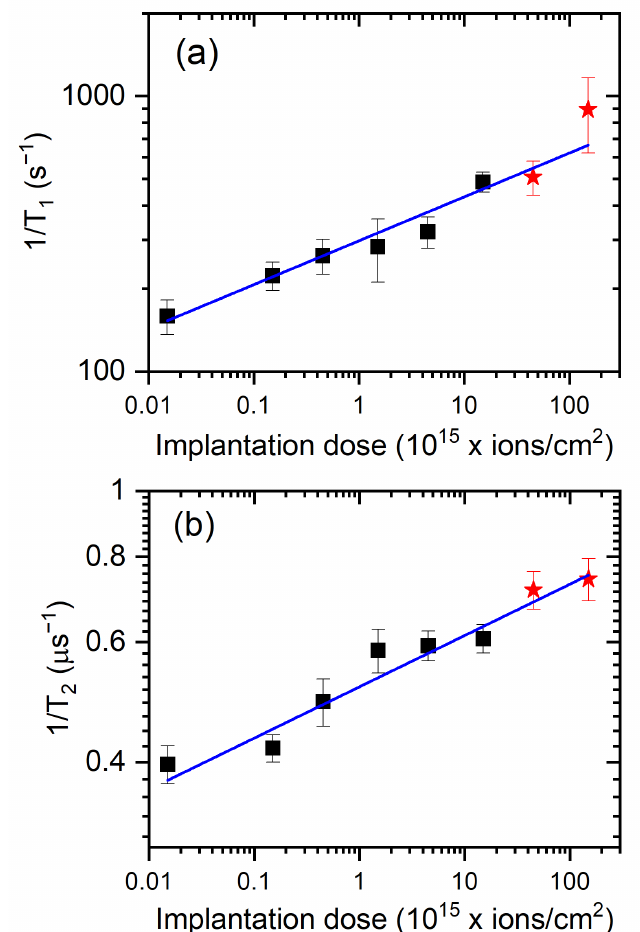
Figure 6. The longitudinal relaxation rate ( a ) and the transverse relaxation rate ( b ) as a function of an implantation dose (black squares-HEN1, red stars-HEN2). Linear functions were fitted to the data on the graphs. The slope for ( a ) was 0.16 and was twice as large as for the data from ( b )